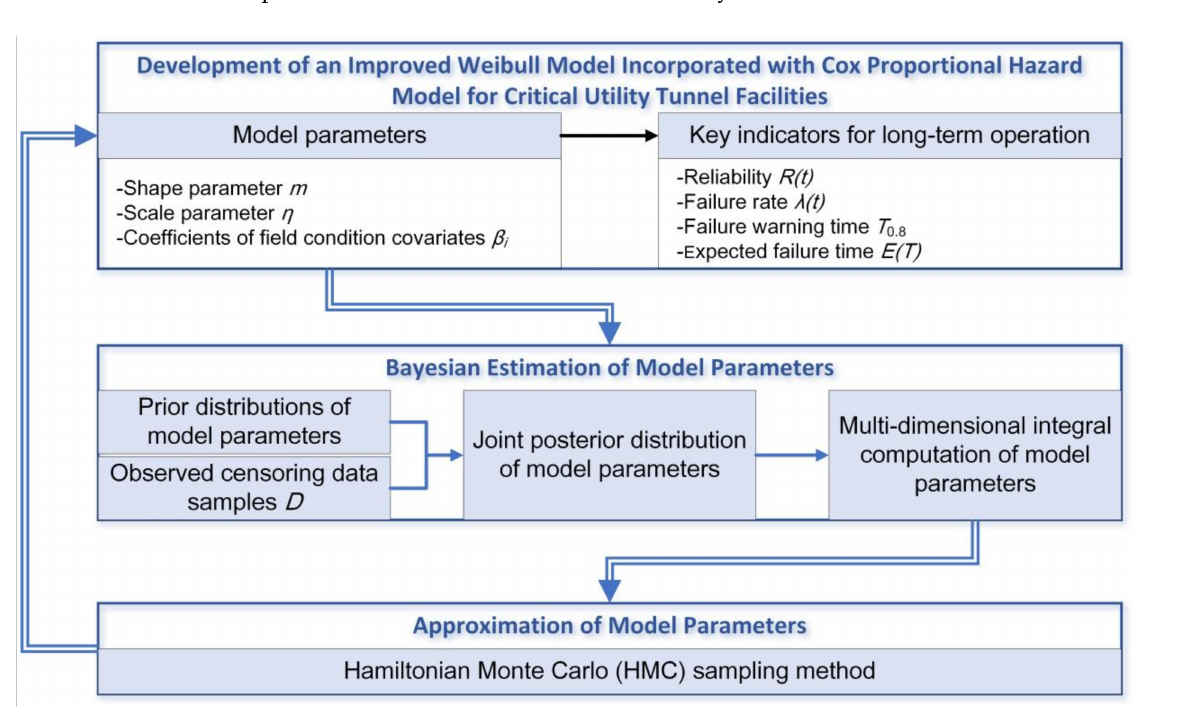
Figure 2. Methodological flow chart of reliability estimation for critical utility tunnel facilities based on an improved Bayesian Weibull